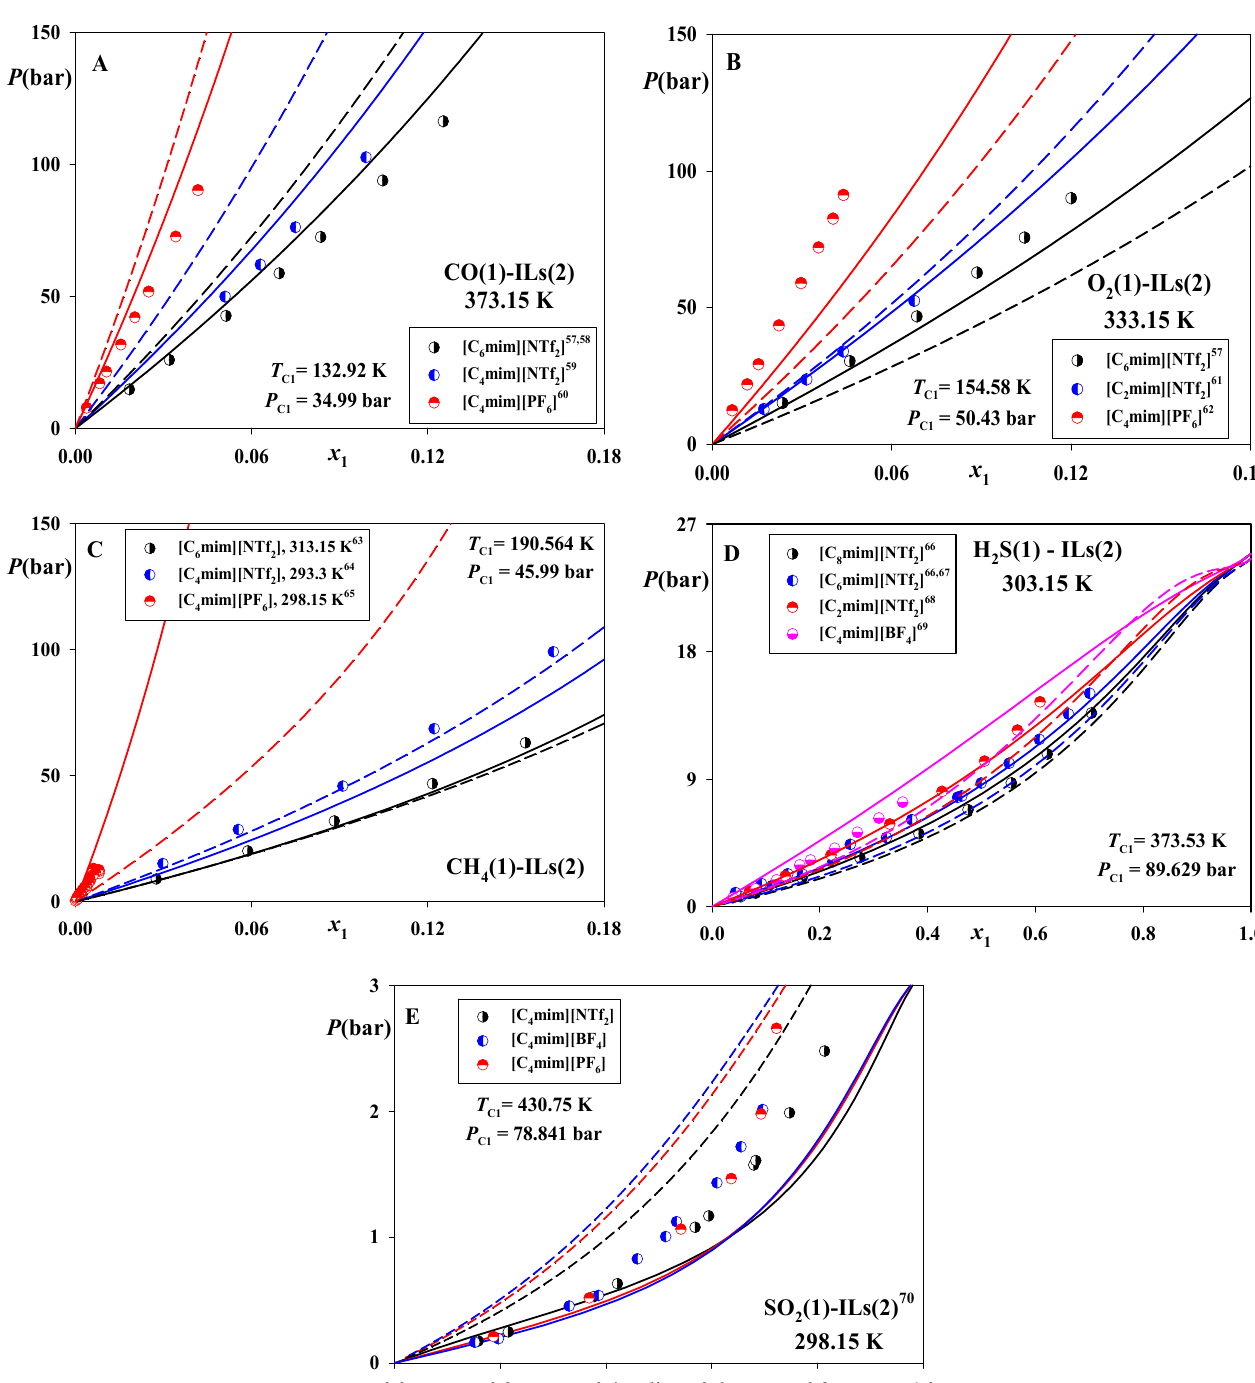
Figure 1. Solubilities of CO, O 2 , CH 4 , H 2 S and SO 2 in [C 2 mim][NTf 2 ], [C 4 mim][NTf 2 ], [C 6 mim][NTf 2 ], [C 8 mim][NTf 2 ], [C 4 mim][BF 4 ] and [C 4 mim][PF 6 ]. Points — experimental data [57,58,59,60,61,62,63,64,65,66,67,68,69,70]. Solid lines — predictions of CP-PC-SAFT, dashed lines — predictions of SAFT-VR-Mie. k 12 = 0 for both models. x1 — mole fraction of the solute gas.